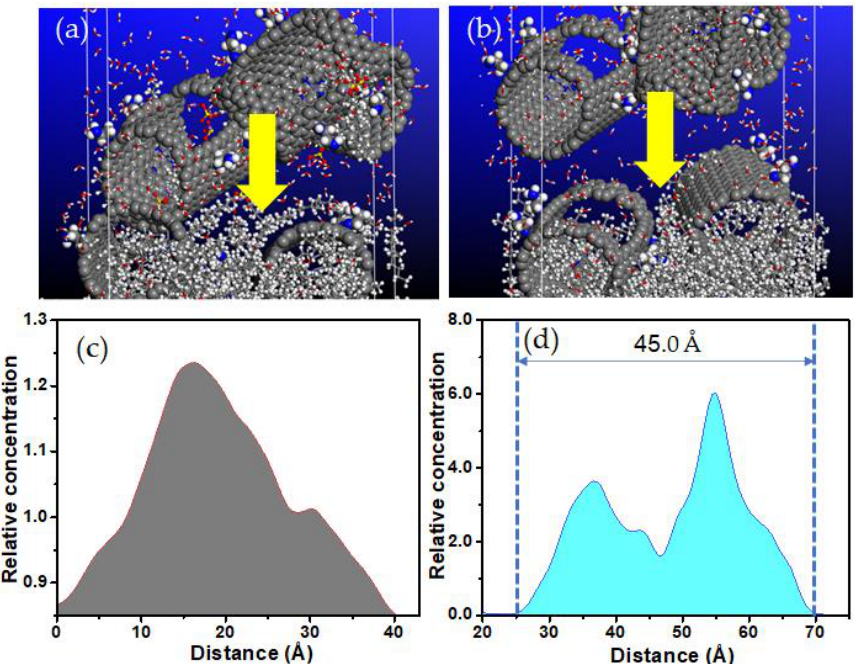
Figure 2. The final frame of the dynamic simulations of the ( a ) membrane-oil – water, and ( b ) the emulsified membrane-oil – water systems. The relative concentration profiles of the membrane-oil – water, and the emulsified membrane-oil – water systems are presented in ( c ) and ( d ), respectively.